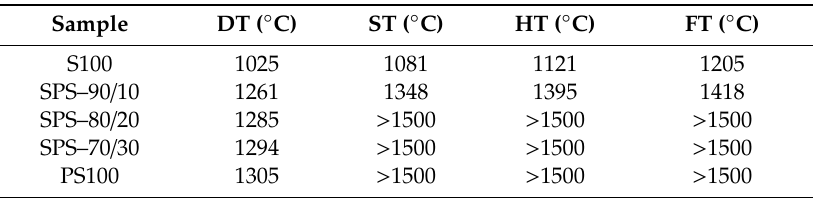
Table 5. Melting points of the samples.